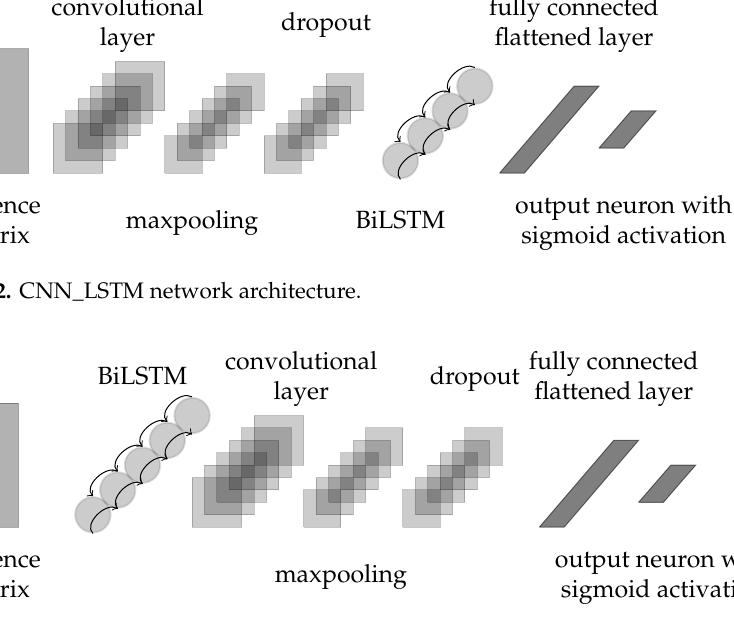
Figure 3. LSTM_CNN network